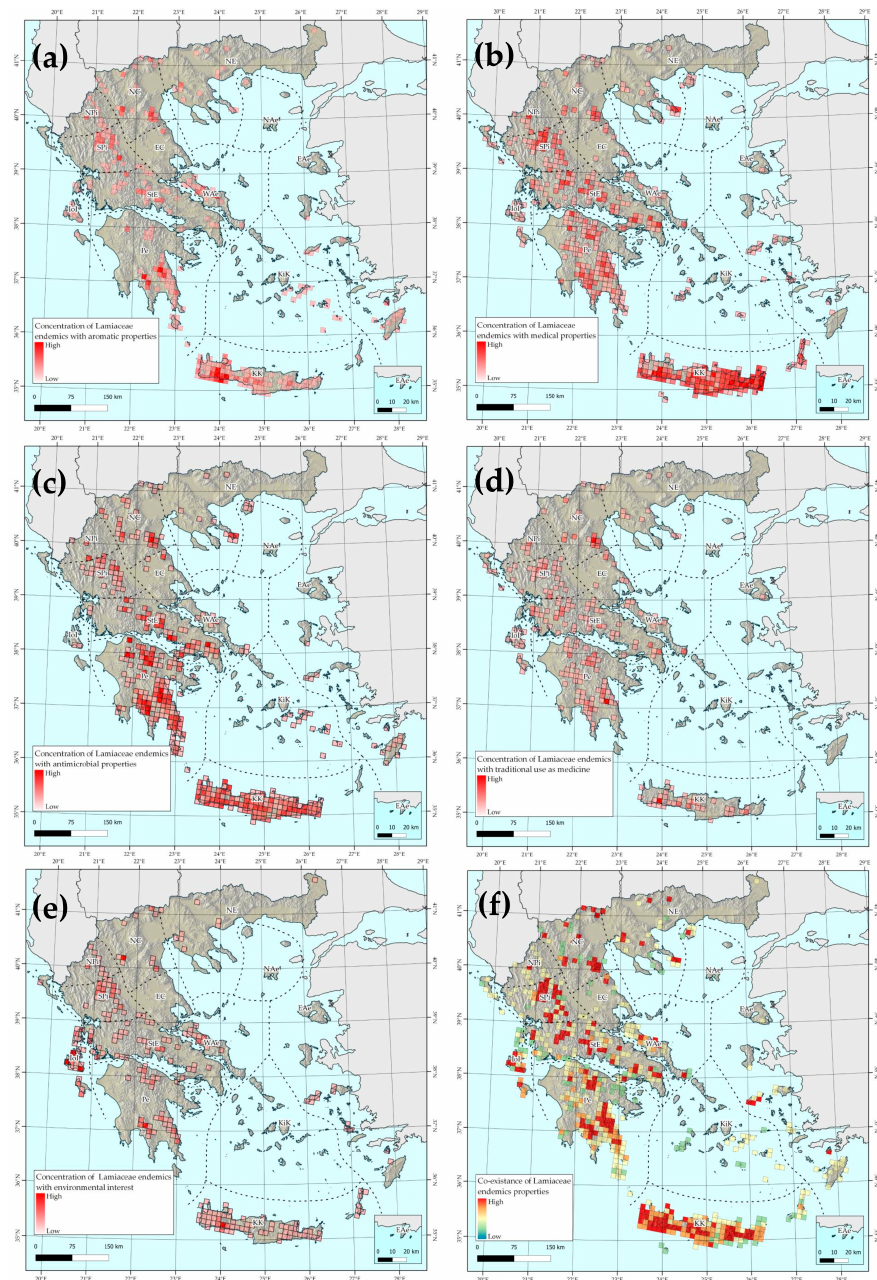
Figure 5. Distribution of the reported properties per endemic taxon using the 10x10 km EEA reference grid; ( a ) aromatic properties, ( b ) medical properties, ( c ) antimicrobial properties, ( d ) traditional medicine, ( e ) environmental interest, ( f ) cumulative representation of the di ff erent properties present per